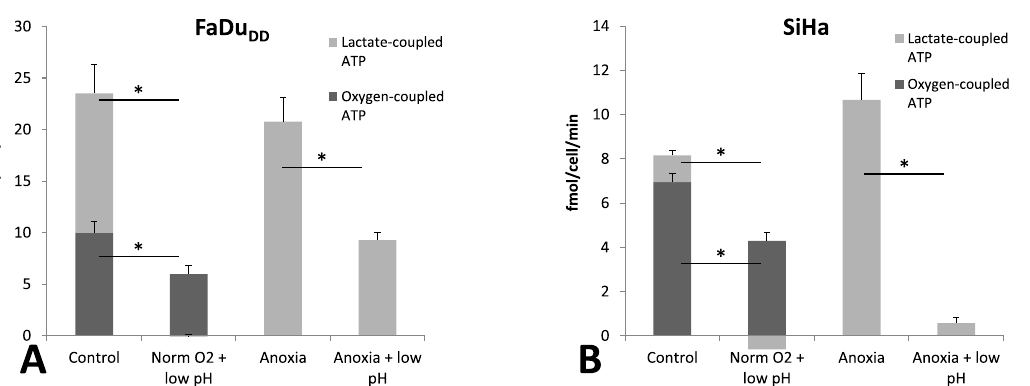
Fig 5. Energy metabolism following acidosis. The cellular ATP budget was calculated from OCR and LPR as detailed in Methods and Materials. The total bar height represents total ATP production, which consists of the sum of ATP generated from OXPHOS (dark gray) and ATP generated from glycolysis (light gray). The data is the mean values from three to four independent experiments (+/- SEM). ( * ) indicates p values < 0.05 between the indicated treatments.